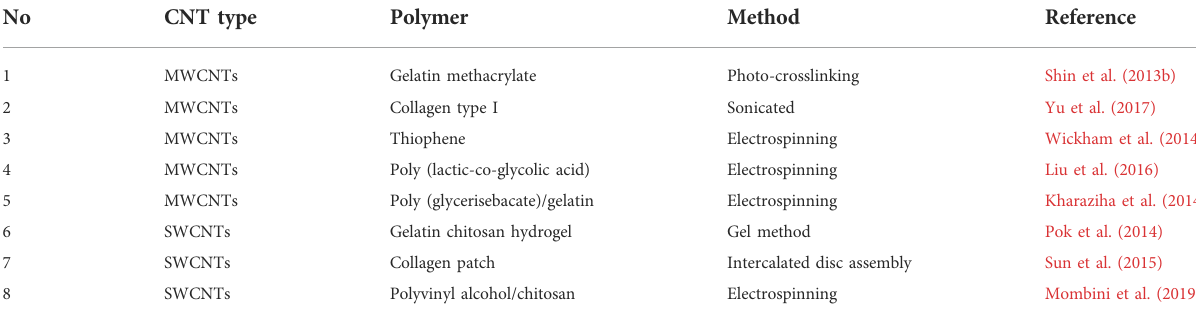
TABLE 2 A list of CNTs with polymers for cardiac tissue